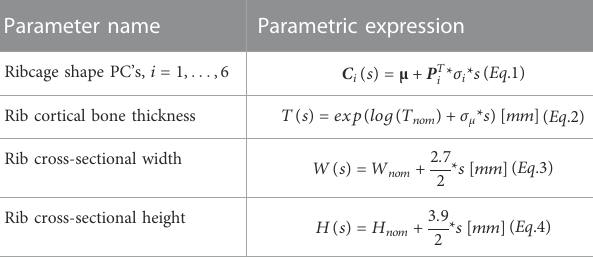
TABLE 1 Parameters modifying rib and ribcage geometrical features and the parametric expressions used. Parameter name Parametric expression Ribcage shape PC ’ s, i (cid:1) 1 , ... ,